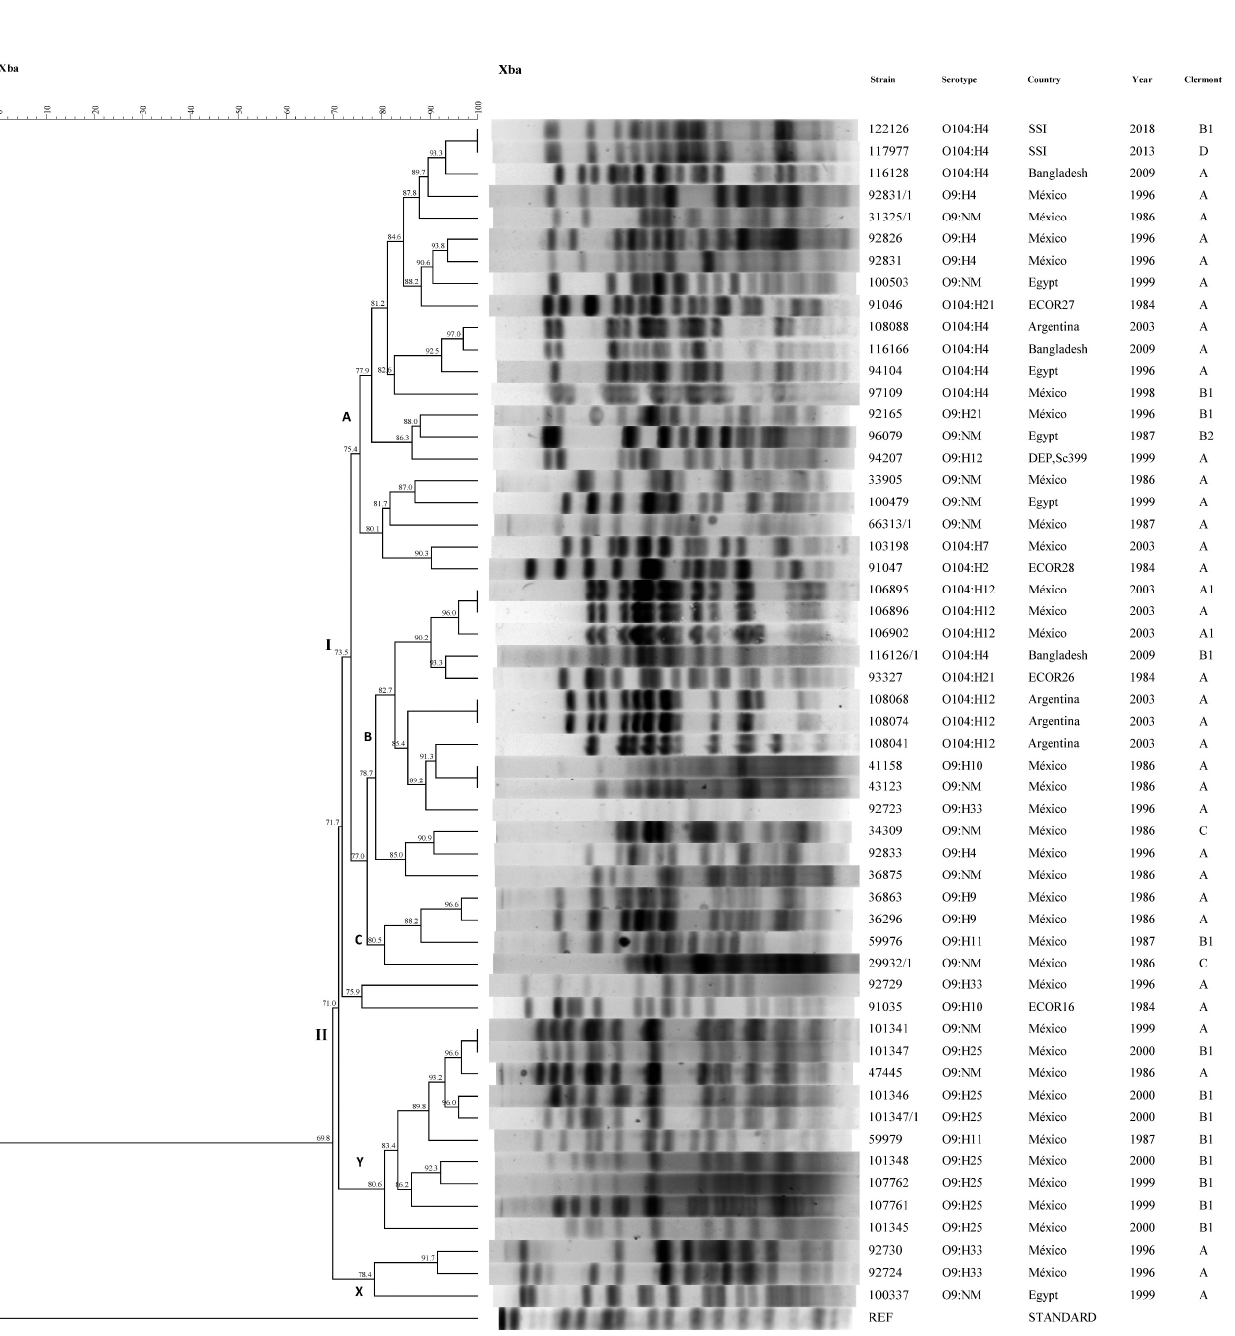
Figure 1. Pulsed-field gel electrophoresis (PFGE). NM: nonmotile.